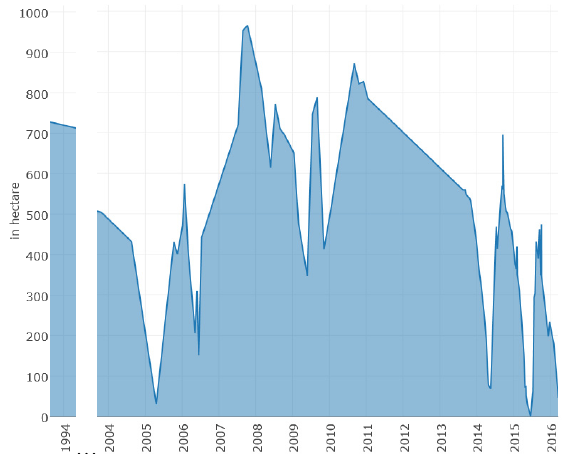
Figure 9. The water surface area in hectare of all 97 suitable SAR scenes from 1993 to 2016.